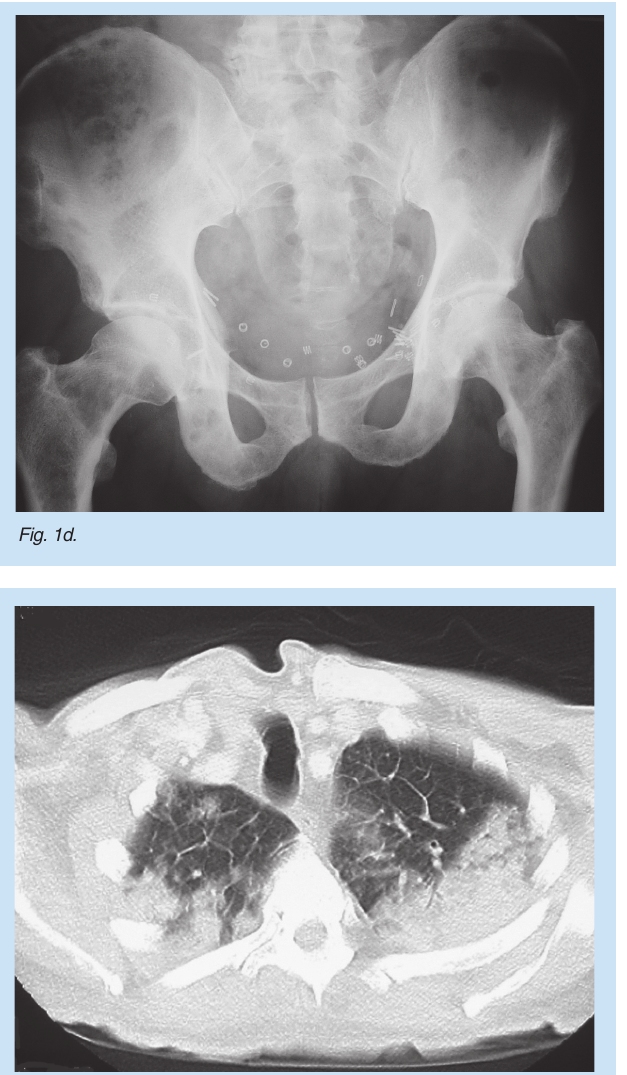
Fig. 2a. CT of the chest – lung windows. Multiple, fairly poorly circum- scribed, subpleural nodules on a background of alveolar airspace disease and pleural effusions. This constitutes most probably metastatic disease on a background of infective changes within the lung parenchyma.